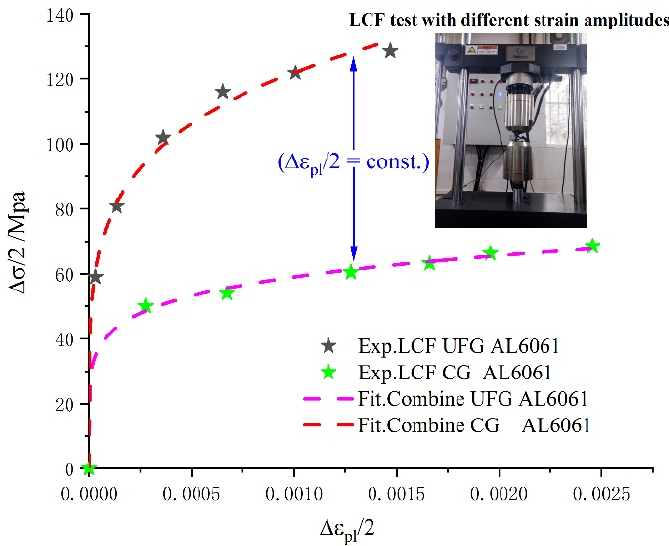
Table 3. Characteristic parameters of UFG 6061AA and CG 6061AA.